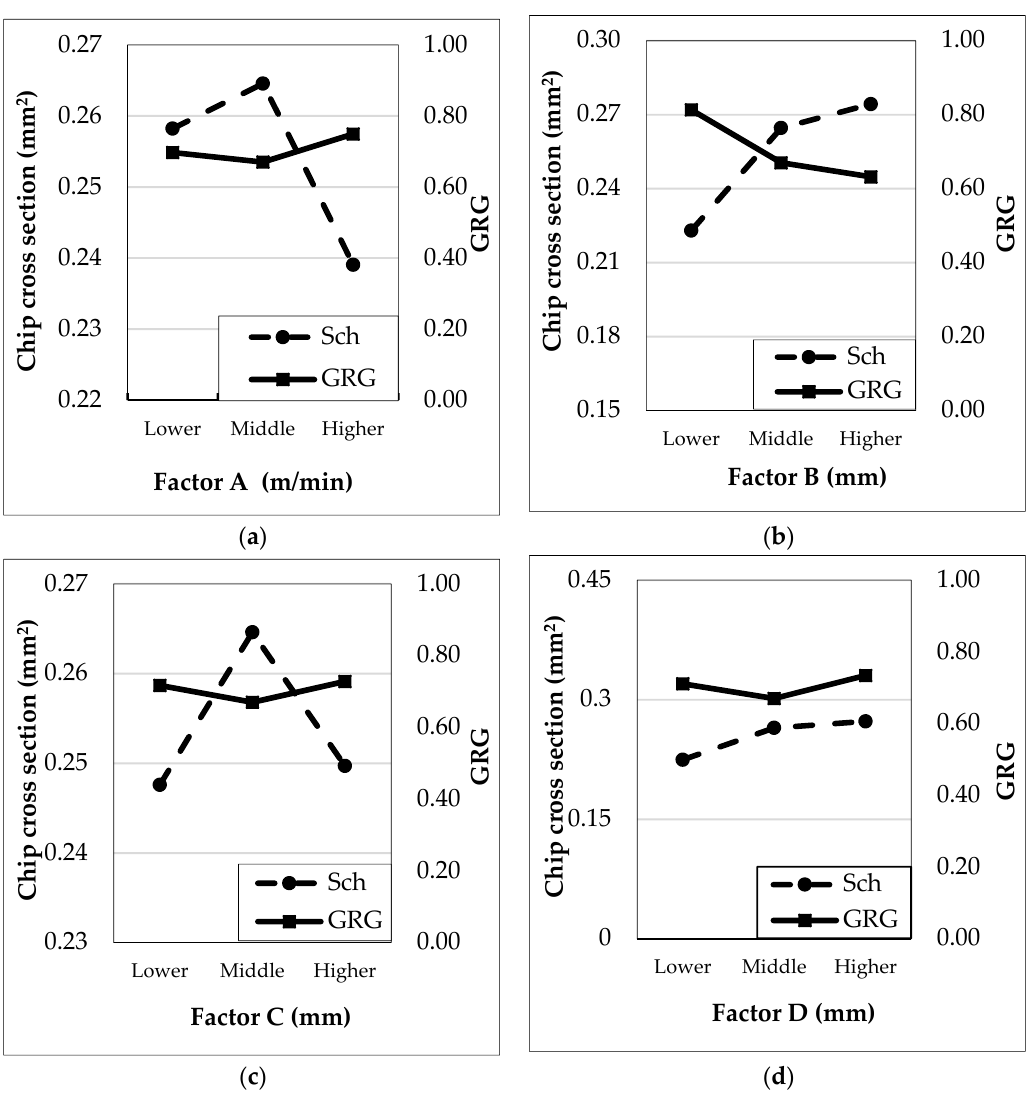
Figure 17 . ( a ) Effect of cutting speed factor (A) on the section of the chip performance characteristic; ( b ) Effect of feed rate factor (B) on the section of the chip performance characteristic; ( c ) Effect of depth od cut factor (C) on the chip performance characteristic; ( d ) Effect of corner radius factor (D) on the section of the chip performance characteristic.